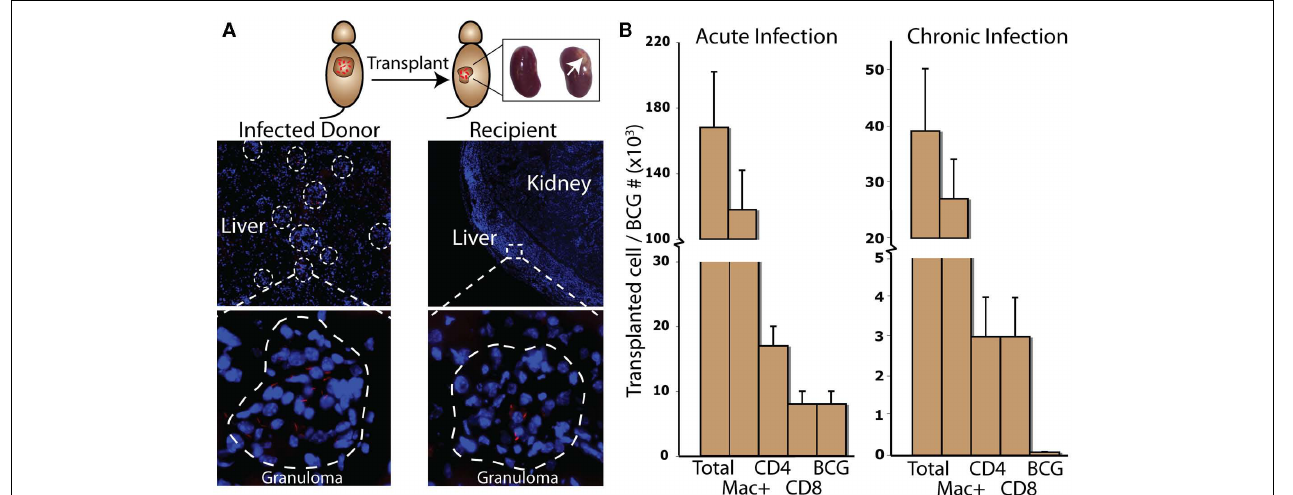
FIGURE 1 | Intraperitoneal infection of BCG in mice results in mycobac- teria-containing liver granulomas [(A), left panels]. In this transplant model, approximately 1% of infected donor liver tissue is transplanted underneath the kidney capsule of recipient mice [ (A) , right panels].The high oxygen/blood-rich